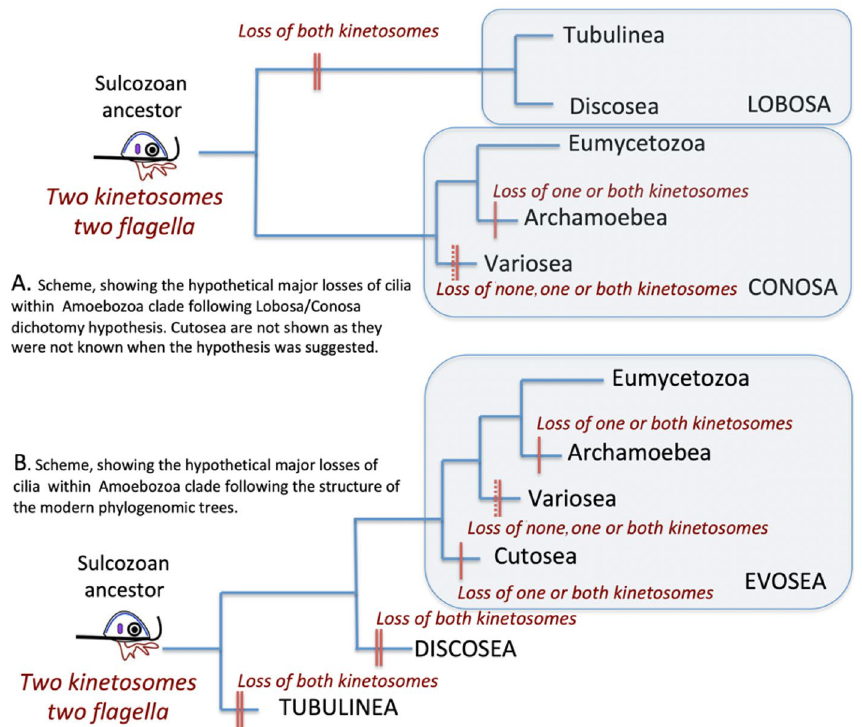
Figure 2. A scheme illustrating the loss of kinetosomes and cilia under the different configurations of the phylogenetic tree ( A and B ). Vertical hash marks on branches show loss of kinetosomes (the number lost as designated by labels on the diagram) depending on the